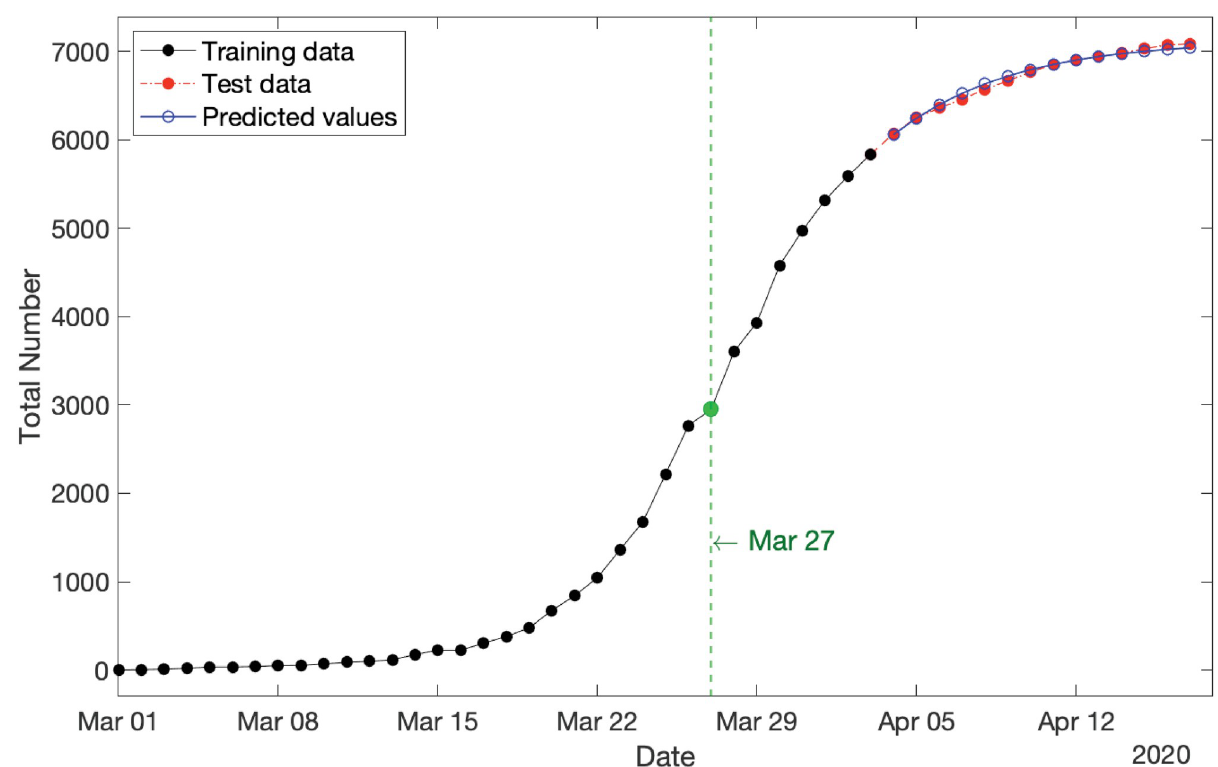
Fig 6. Cumulative new COVID-19 cases in Australia for three categories: (i) training data spanning 1 March–3 April 2020 (in black), test data spanning 4 − 17 April 2020 (in red), and (iii) predicted values over the period of test data (in blue) with MAPE = 0.43%. The first break point on 27 March 2020 is marked in